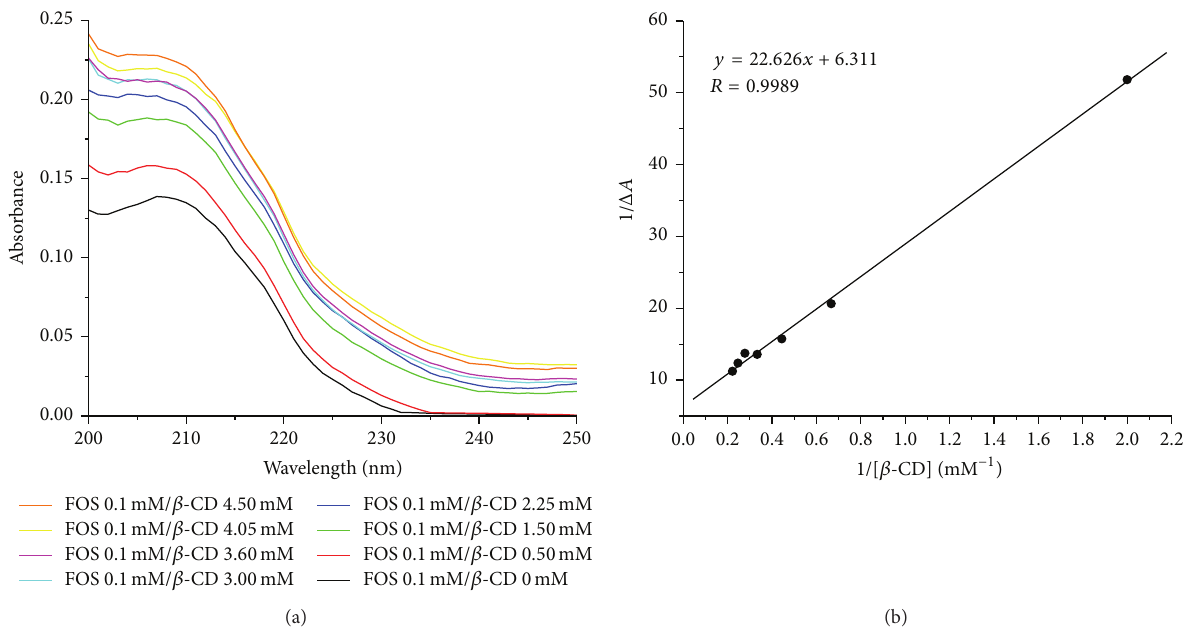
Figure 3: (a) Ultraviolet spectra of pure Fos and Fos/ 𝛽 -CD inclusion complex in presence of increasing 𝛽 -CD concentration; (b) Benesi- Hildebrand linear plot for 1/ Δ𝐴 versus 1/ 𝛽